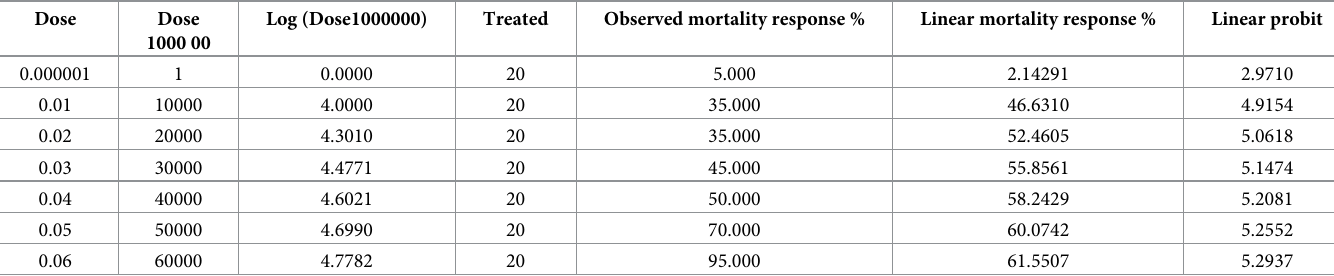
Table 1. Dose-response percentages of NiO-NPs in the studied groups.